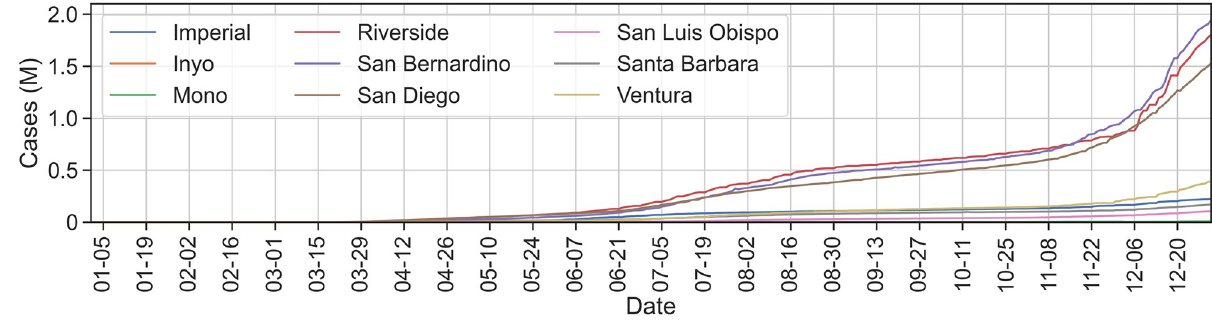
Fig 12. Total cases for all SoCal counties, excluding LA and OR. Case totals are highest for Riverside, San Bernardino, and San Diego